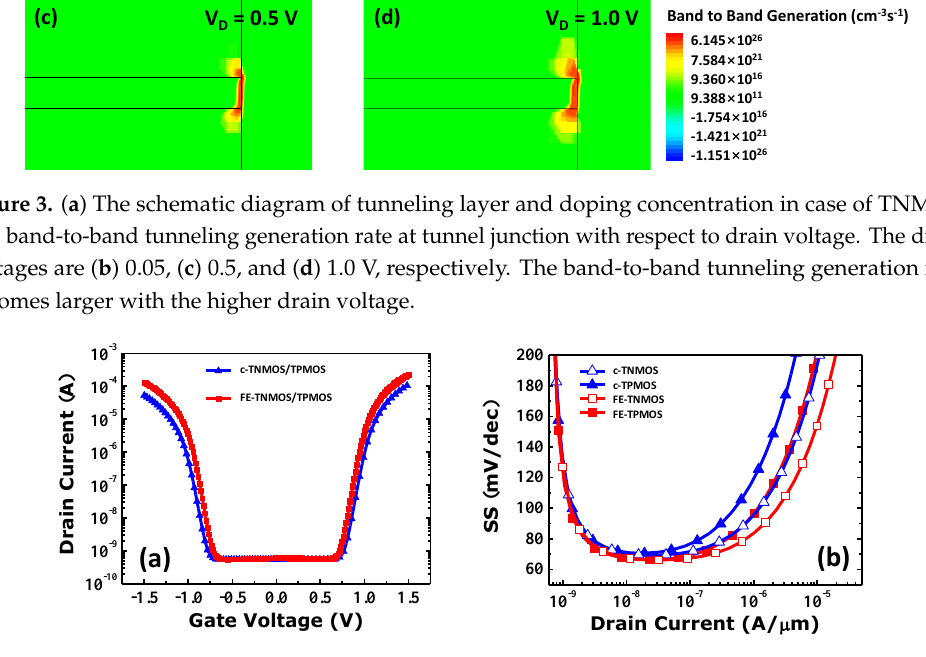
Figure 3. (a) The schematic diagram of tunneling layer and doping concentration in case of TNMOS. The band-to-band tunneling generation rate at tunnel junction with respect to drain voltage. The drain voltages are (b) 0.05, (c) 0.5, and (d) 1.0 V, respectively. The band-to-band tunneling generation rate becomes larger with the higher drain voltage.